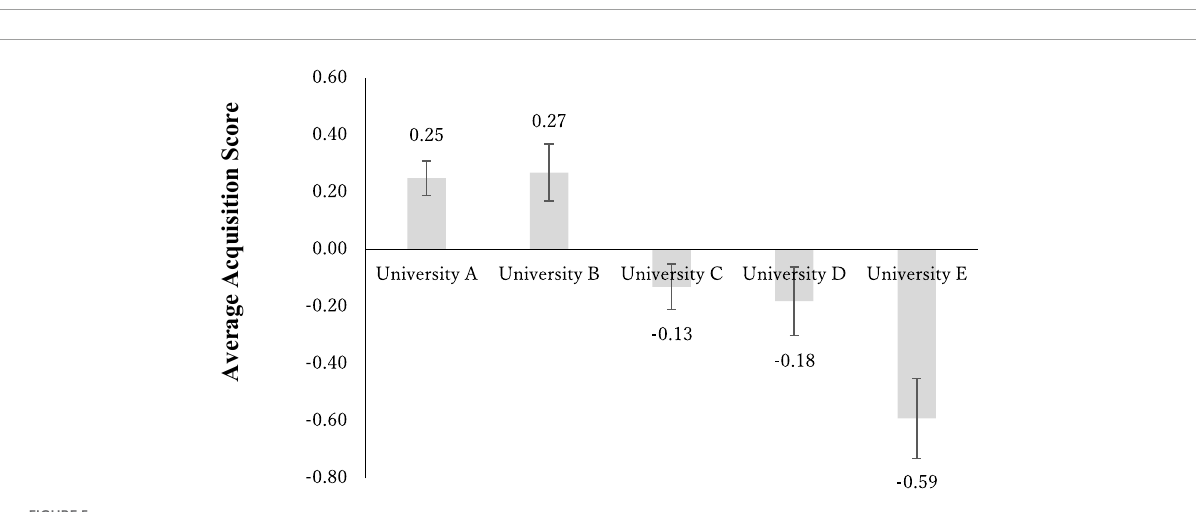
FIGURE5 Average acquisition scores for students in each university. The vertical bars show the standard